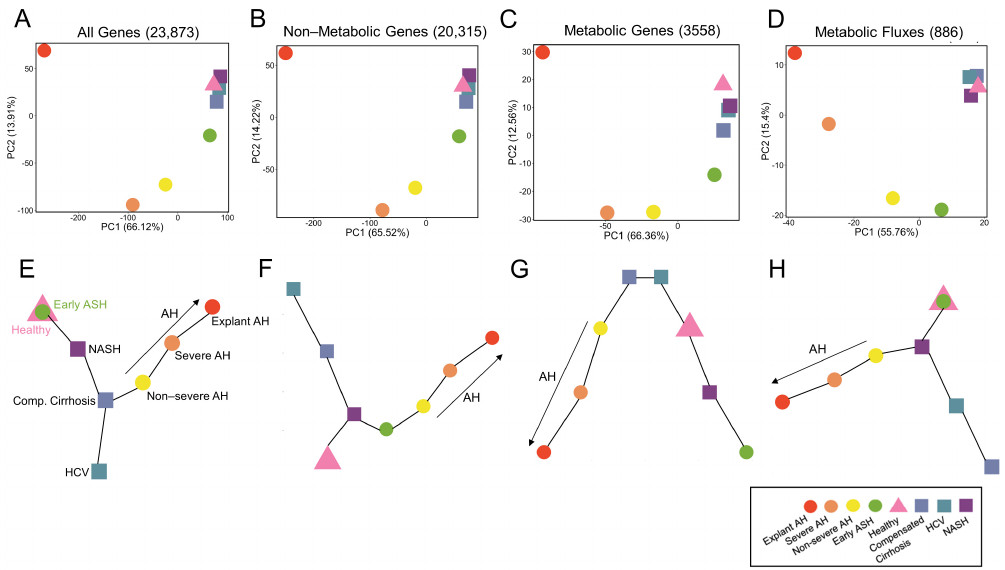
Figure 4. Systems-level analysis of RNA-seq data and predicted metabolic fluxes. Principal compo- nent analysis (PCA) plots are shown for ( A ) all 23,873 genes, ( B ) 20,315 non-metabolic genes, ( C ) 3558 metabolic genes, and ( D ) 886 metabolic fluxes. The percent variability for PC1 and PC2 are shown. Minimum spanning trees (MST) are shown for ( E ) all genes, ( F ) non-metabolic genes, ( G ) metabolic genes, and ( H ) metabolic fluxes. In all MST plots, progressing AH disease severity is shown.